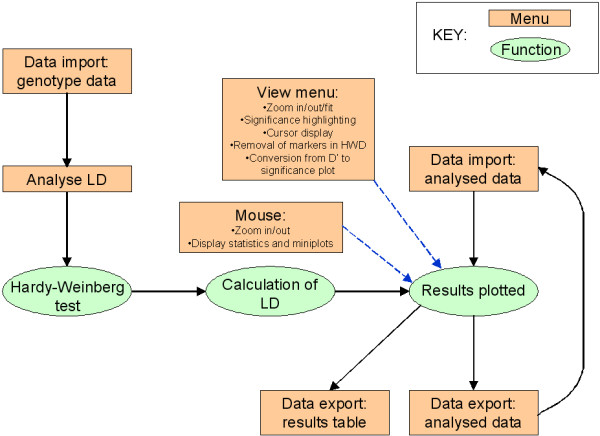
Flow-chart of MIDAS from the users perspective. Rectangles indicate user inputs, ovals indicate program functions.